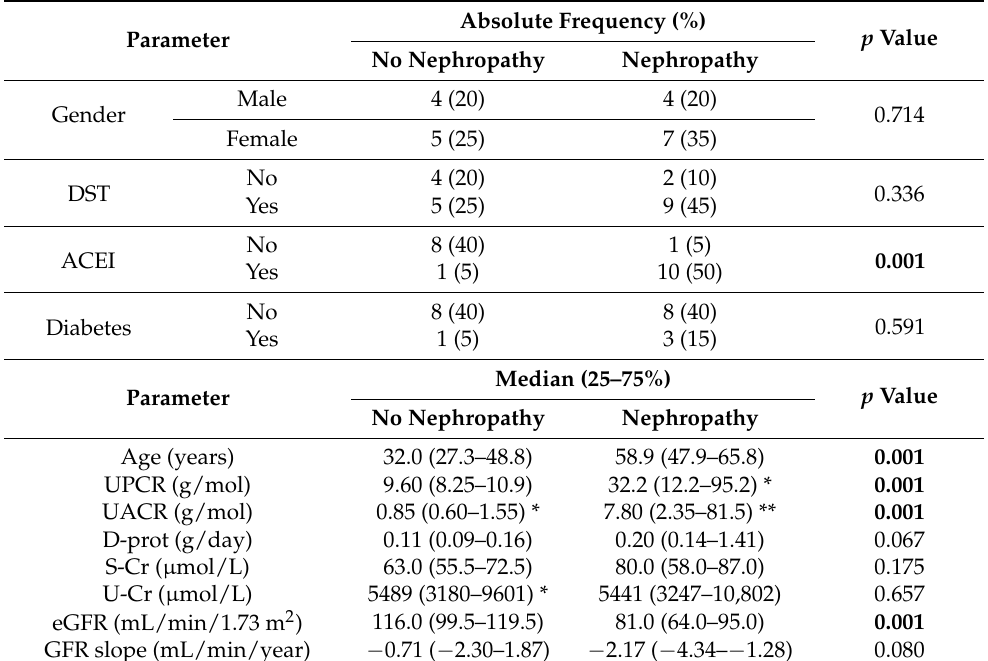
Table 3. Patients’ characteristics at last follow-up ( n =